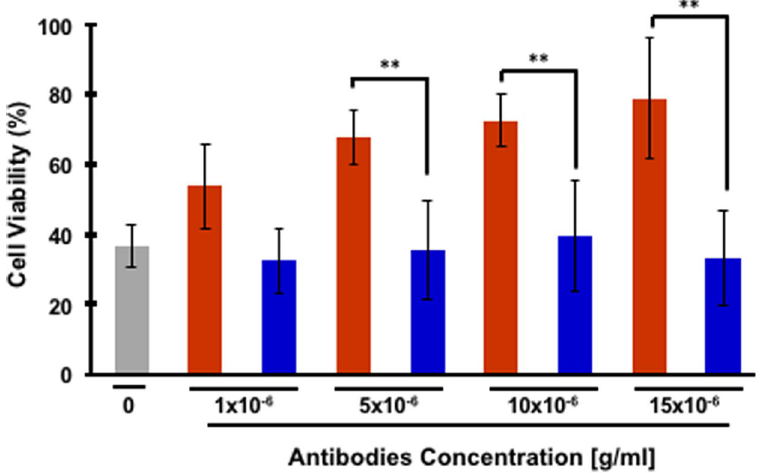
Figure 4. Antibodies derived from immunized mice recognize and neutralize hIAPP oligomers. Rin-m cells were treated with hIAPP oligomers with or without antibodies derived from the immunized (red) or the mock group (blue) at various concentrations. Cell viability was determined by the MTT reduction assay and treated and non-treated cells were compared (values are means ± s.d., Student’s t-test ** P <